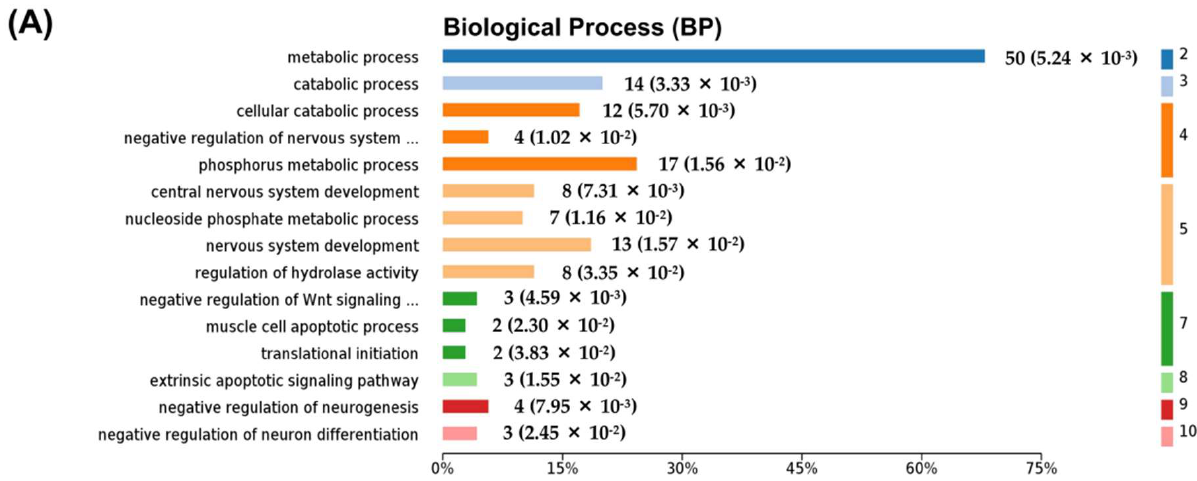
synapse, and neuron part, respectively. ↑ , upregulated; ↓ , downregulated.